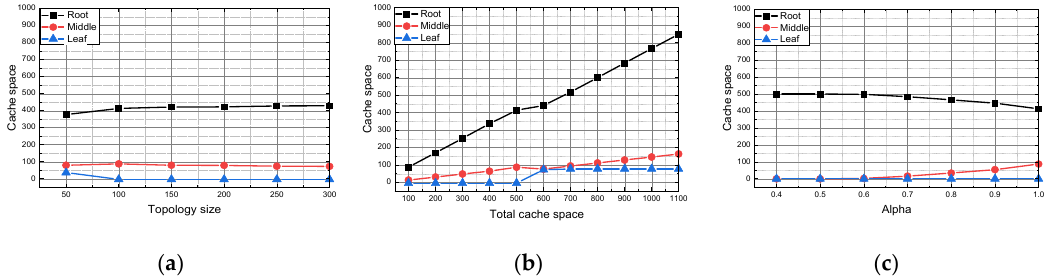
Figure 6. Cache space allocated in different layers. (a)The allocated cache space under different topology sizes. (b)The allocated cache space under different total cache budget. (c)The allocated cache space under different Zipf parameter Alpha.